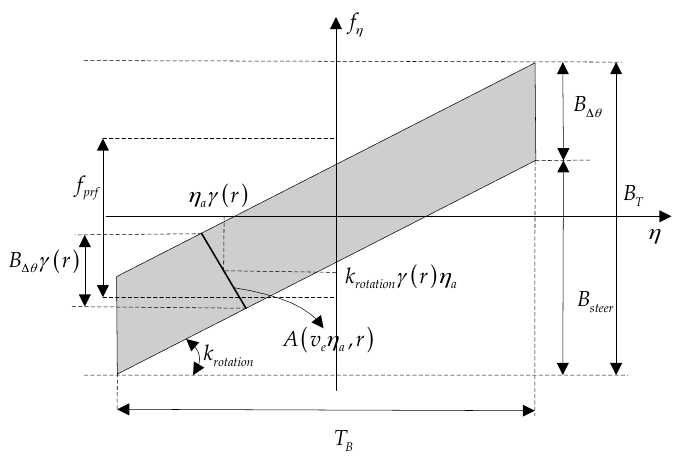
Figure 3 . Azimuth time-frequency diagram of TOPS mode. Figure 3. Azimuth time-frequency diagram of TOPS